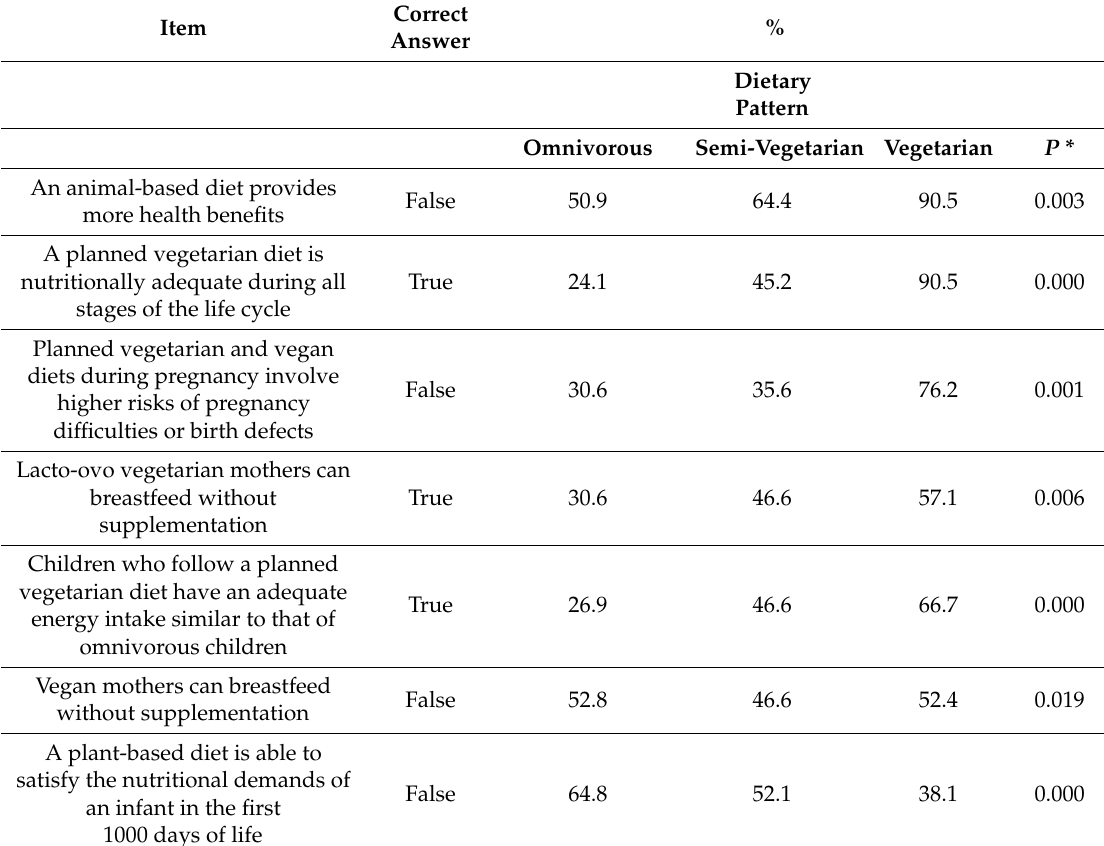
Table 4. Significant relationships between the interviewees’ survey answers and their dietary